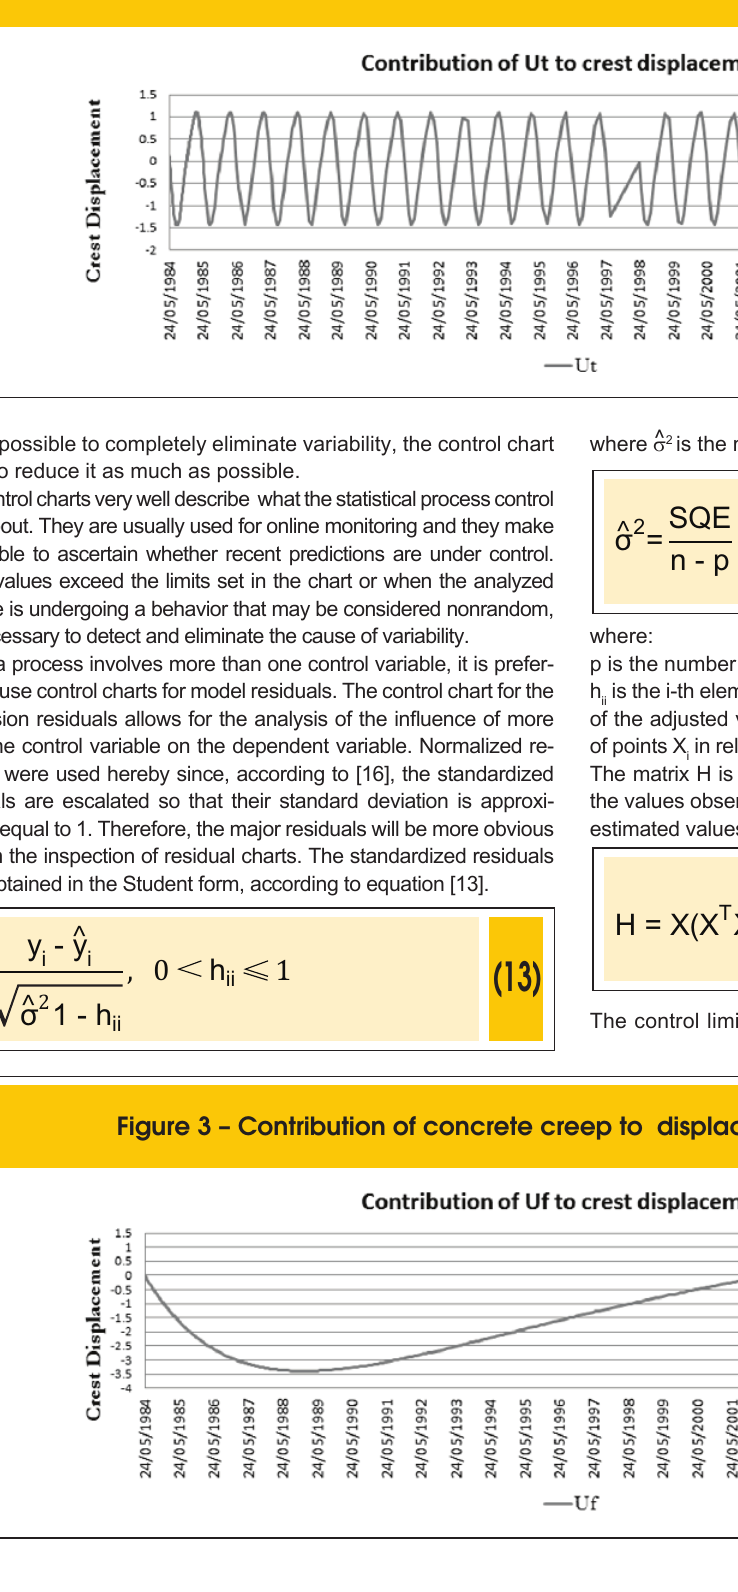
Figure 2 – Contribution of the temperature to displacement of the dam crest